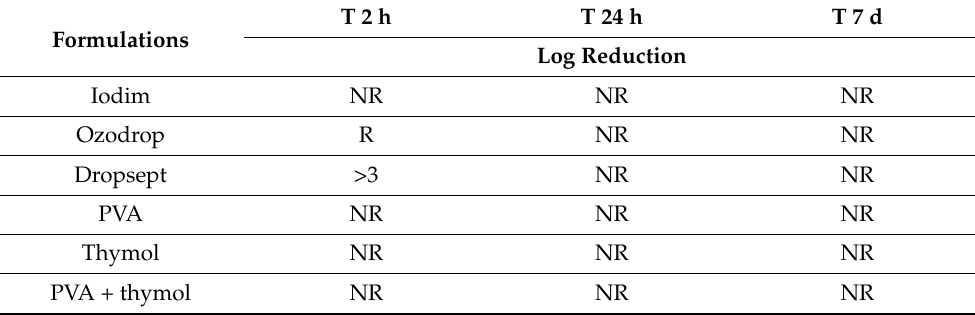
Table 7. Challenge test on S. epidermidis .